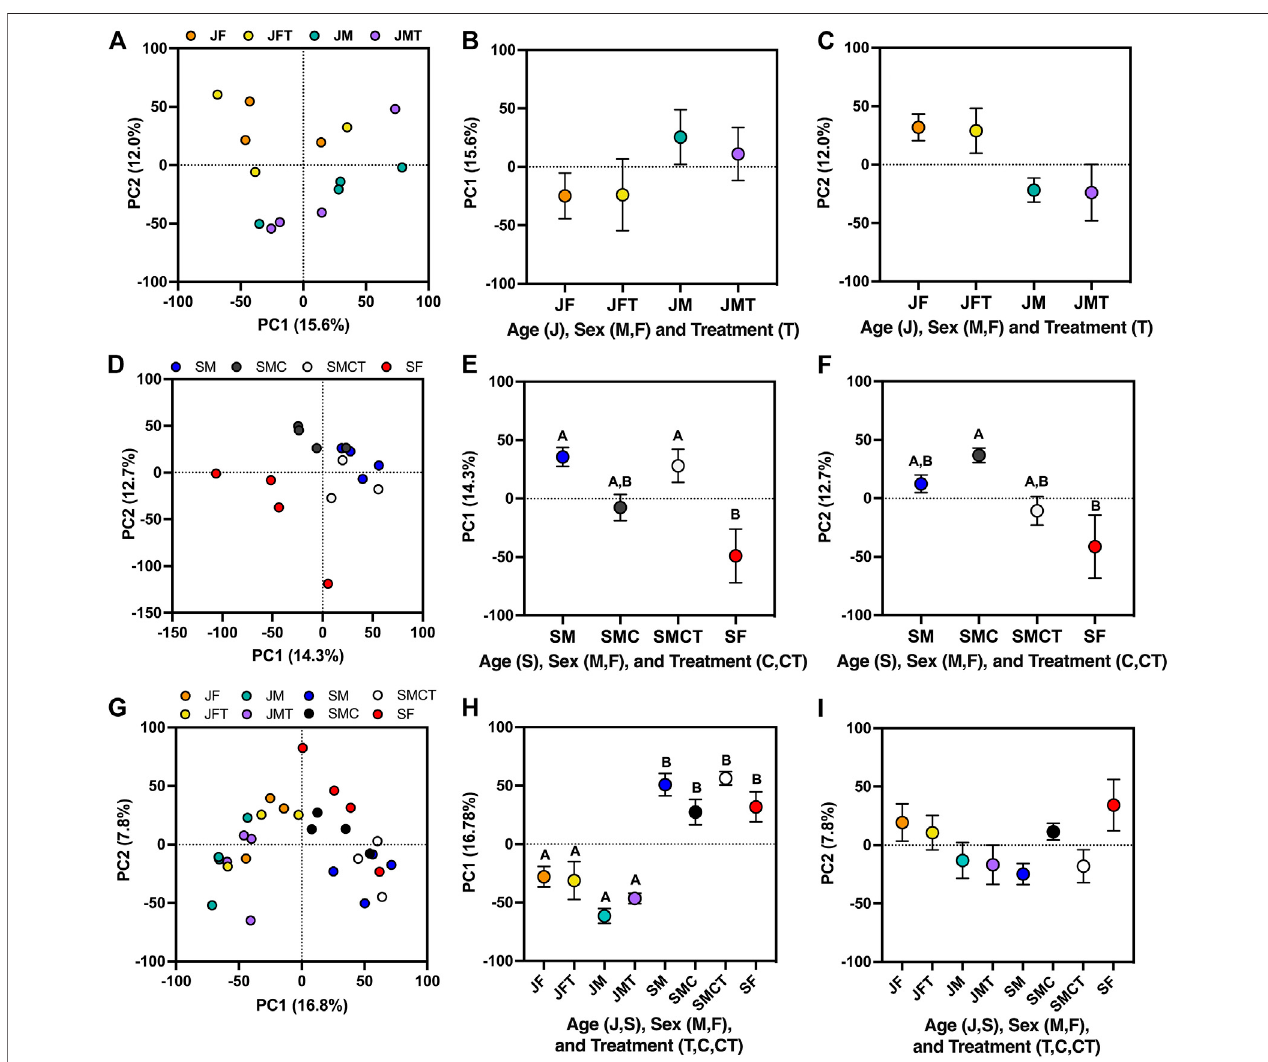
FIGURE 3 | Principle components analyses illustrating effects of testosterone on multivariate patterns of gene expression. (A) Separation of samples from juvenile females and males with empty implants (JF, JM) or testosterone implants (JFT, JMT) alongthe fi rst twoprincipal components, alongside mean (±SE) values for (B) PC1, and (C) PC2ineachgroup.Two-wayANOVArevealedasigni fi canteffectofsexonPC2values(notshown). (D) Separationofsamplesfromsubadultfemalesandmales withemptyimplants(SF,SM)andcastratedsubadultmaleswithemptyimplantsortestosteroneimplants(SMC,SMCT)alongPC1andPC2,alongsidemean(±SE) valuesfor (E) PC1,and (F) PC2ineachgroup.Lettersaboveeachsymbolindicatepost-hocseparationbasedonone-wayANOVA. (G) Separationofsamplesfromeach of the eight juvenile and subadult groups described above along PC1 and PC2, alongside mean (±SE) values for (H) PC1, and (I) PC2 in each group.